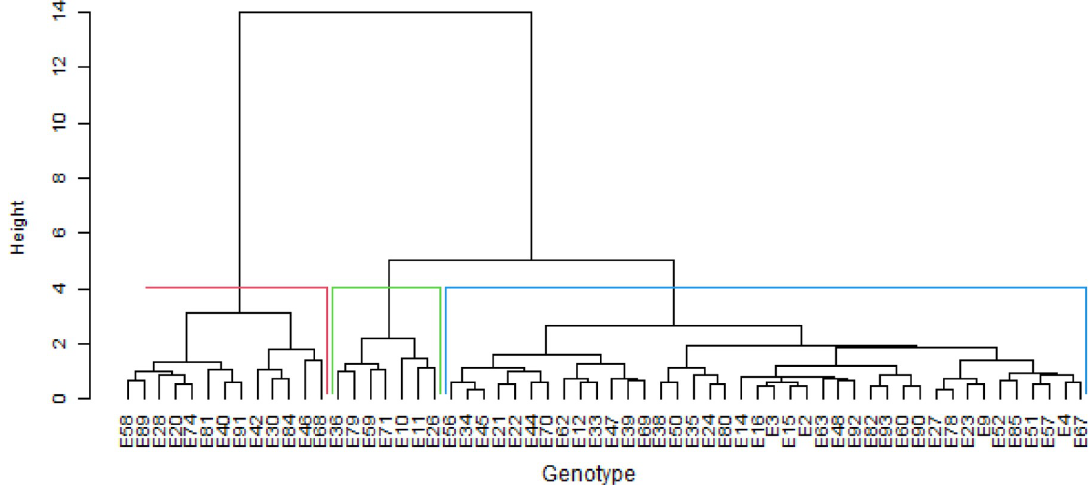
Fig 7. Dendrogram showing genetic relatedness among the 60 common bean genotypes based on the combined matrix.